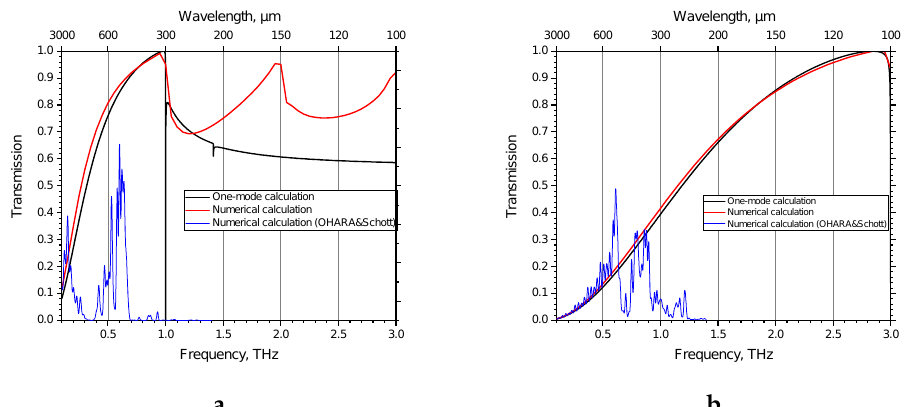
Figure 5. Numerical calculation of the transmission of sample 1 ( a ) and sample 2 ( b ): numerical calculation of the transmission of a free-standing mesh structure and a mesh structure on OHARA S-BSL7/Schott N-BK7 glass. One-mode calculation of free-standing mesh structure